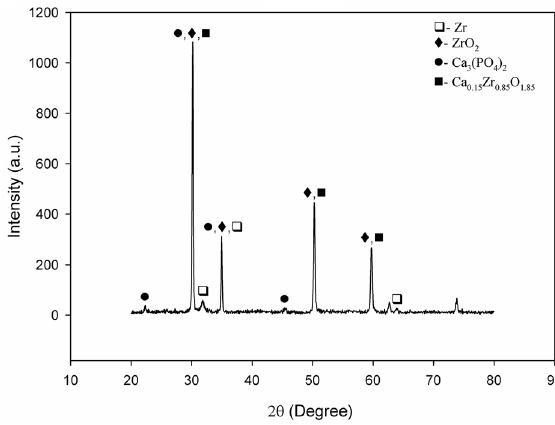
Figure 1. XRD spectra of the MAO